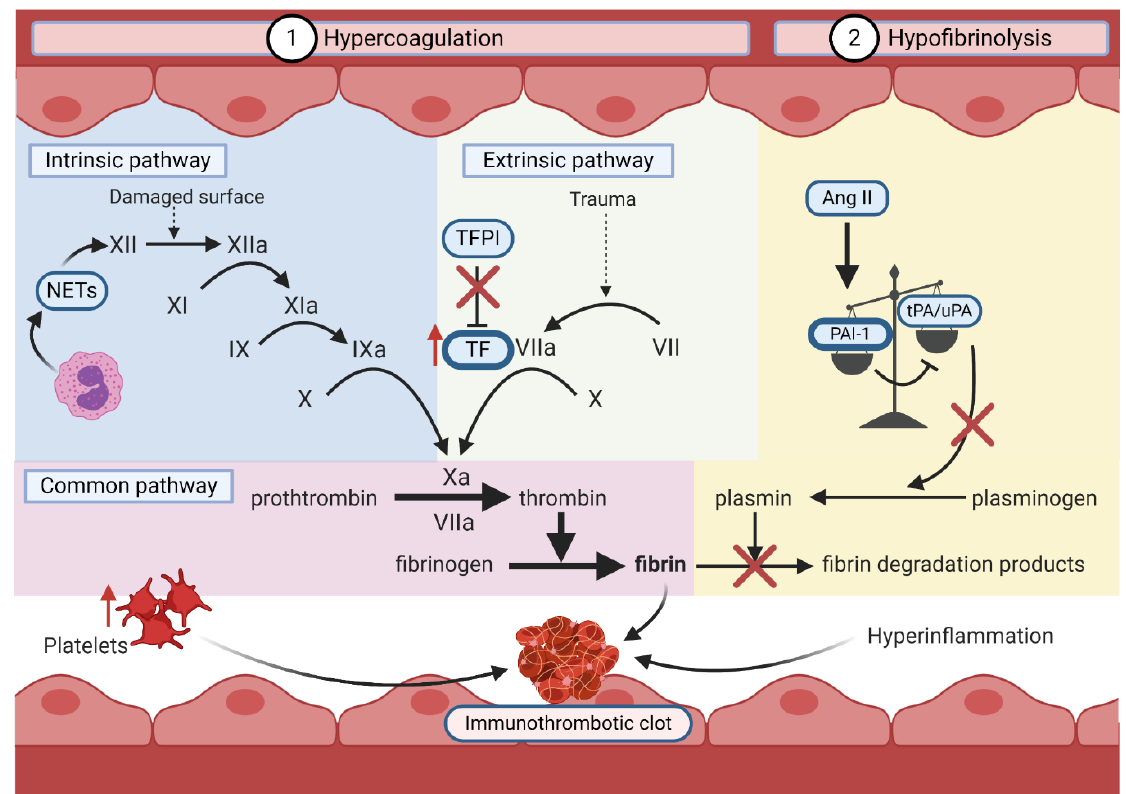
Figure 5. Endothelial dysfunction leads to immunothrombosis by inducing a pro-thrombotic state, hyperinflammation, and increasing platelets. Deleterious thrombosis is mediated by hypercoagulation and hypofibrinolysis. (1) The intrinsic coagulation pathway is stimulated by vascular endothelial damage and NET formation by PMNs. The extrinsic pathway is stimulated by COVID-19-mediated TF upregulation and TFPI inhibition. These pathways converge on the common pathway, promoting hypercoagulation through excessive fibrin formation. (2) Fibrinolysis is inhibited by the Ang II-mediated increased PAI-1:tPA/uPA ratio. Together, accumulation of fibrin, platelets, and hyperinflammation due to endothelial dysfunction contribute to the formation of immunothrombotic clots.